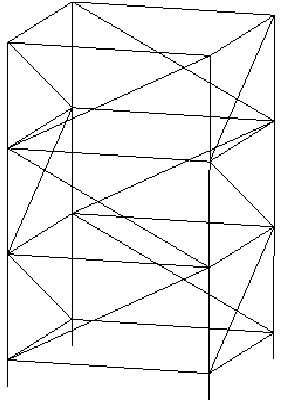
Figure 15. Offshore platform truss structure model. Table 4. Offshore platform pipeline parameters.